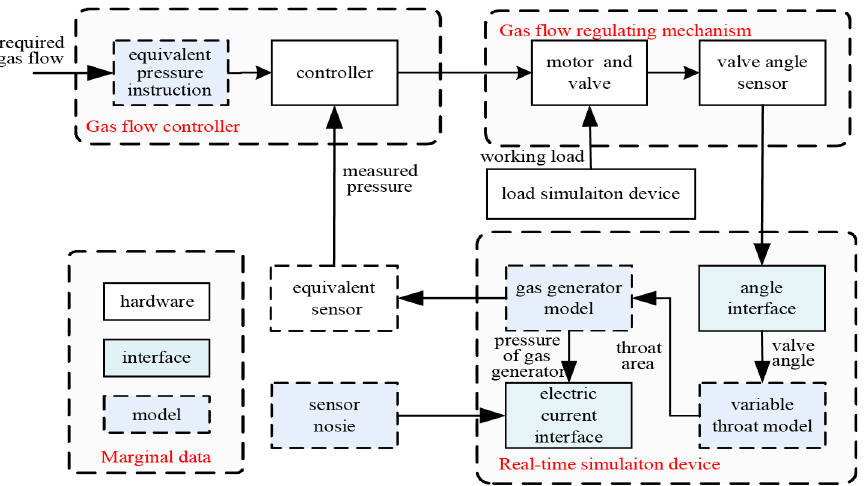
Figure 12. Schematic of the HIL system.